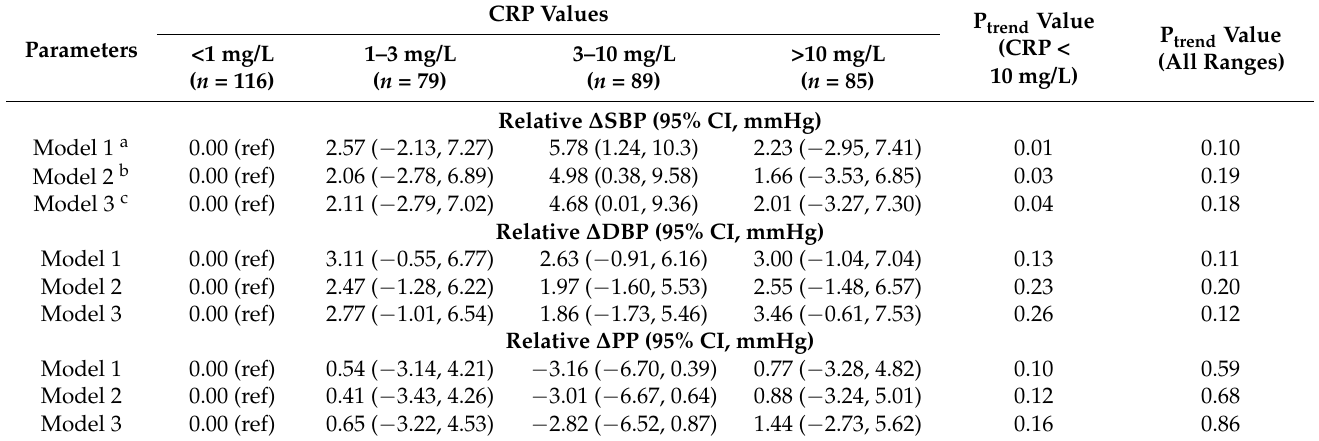
Table 3. Relative changes of blood pressure by baseline CRP